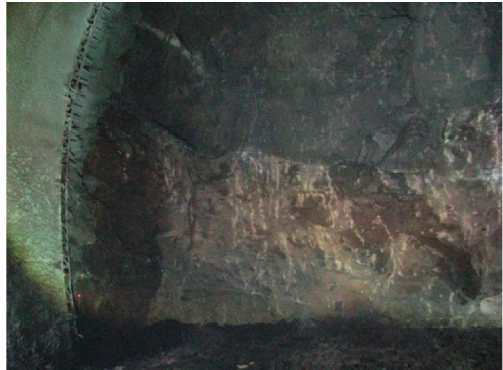
Figure 11: The actual contour at DK247+